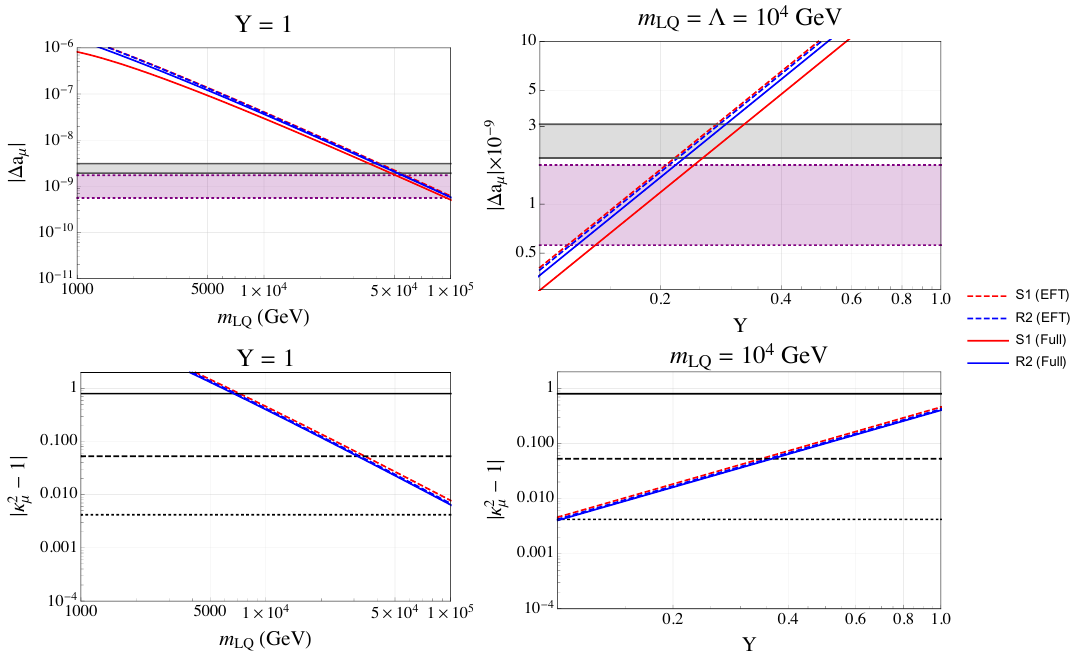
Figure 10 . Top : shift to muon anomalous magnetic moment induced by LeptoQuarks for different values of m LQ , with fixed couplings to muons and top quarks (left) and for different values of the coupling Y , with fixed LQ mass m LQ = Λ = 10 4 GeV (right). The red and blue dashed lines show the result of matching LQ models to SMEFT operators using eq. (6.5) as initial condition and running to the weak scale for S 1 and R 2 case respectively. The red and blue solid lines are obtained using the results in ref. [21]. Bottom : same for the shift to Higgs to two muons decay. The black solid, dashed and dotted lines represent lower bounds on | κ 2 − 1 | from LHC, HL-LHC and FCC µ respectively (see section 4.2 for details). Note that the solid lines overlap in these